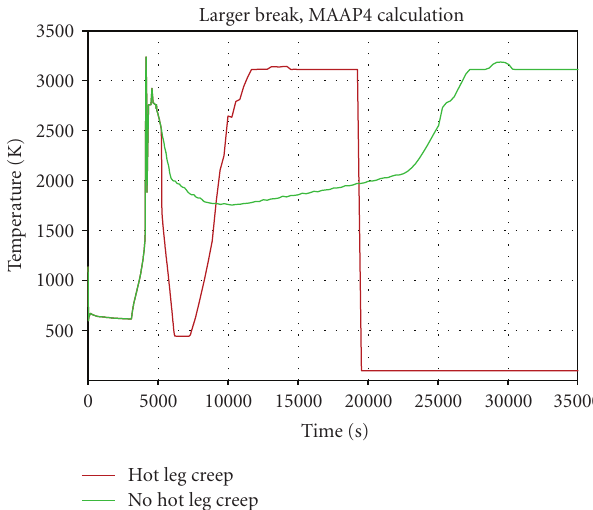
Figure 14: Core maximum temperature, MAAP4 calculation, Group 2.